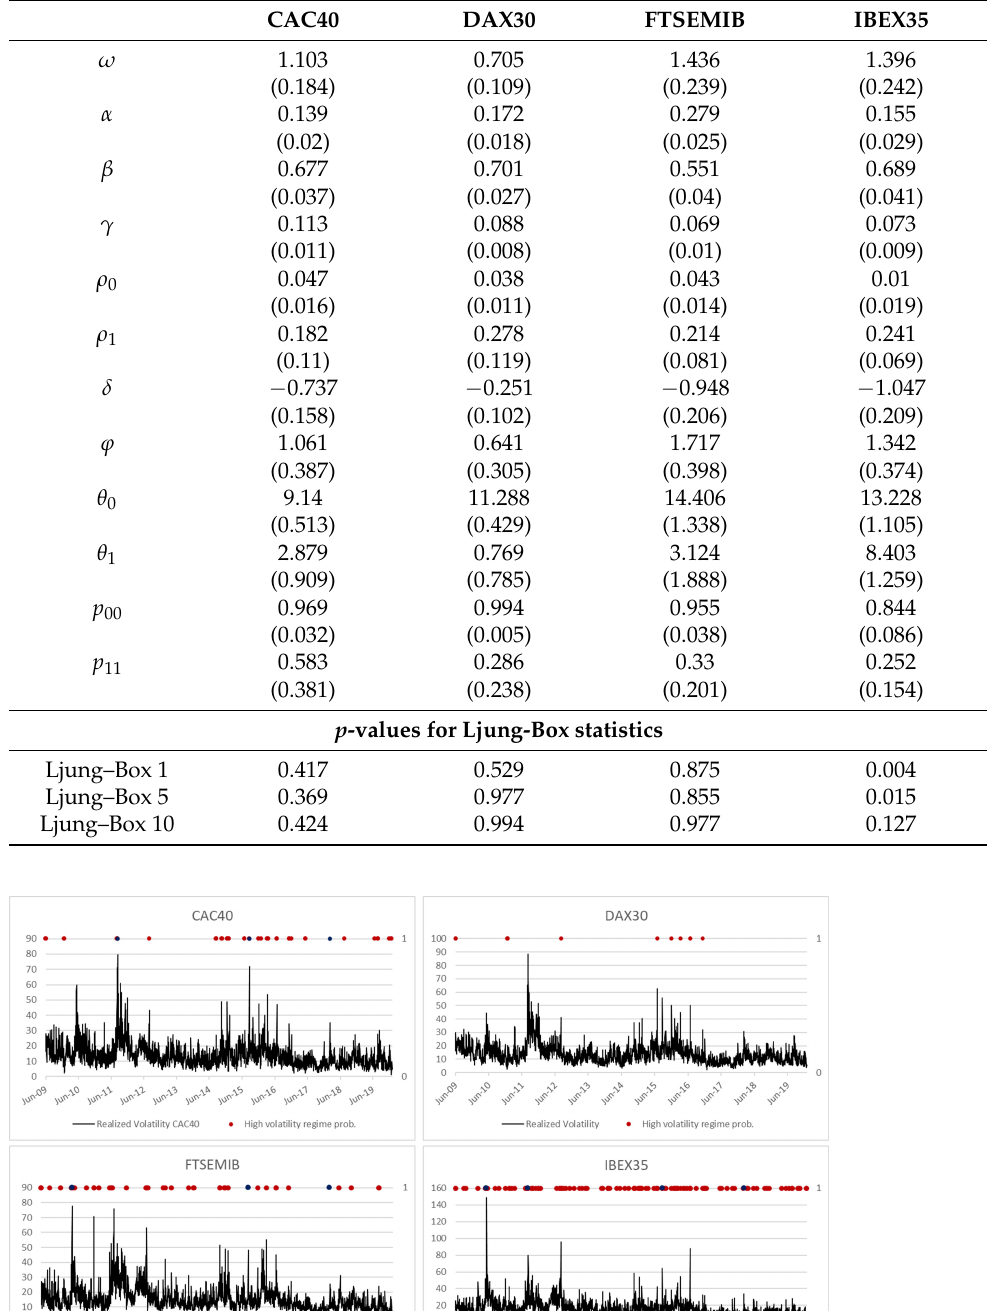
Table 4. Model Estimation results from the MS-AMEMX (robust s.e. in parenthesis) and p -values for the Ljung–Box statistics. Estimation period: 1 June 2009–31 December 2019. Dependent Variable: